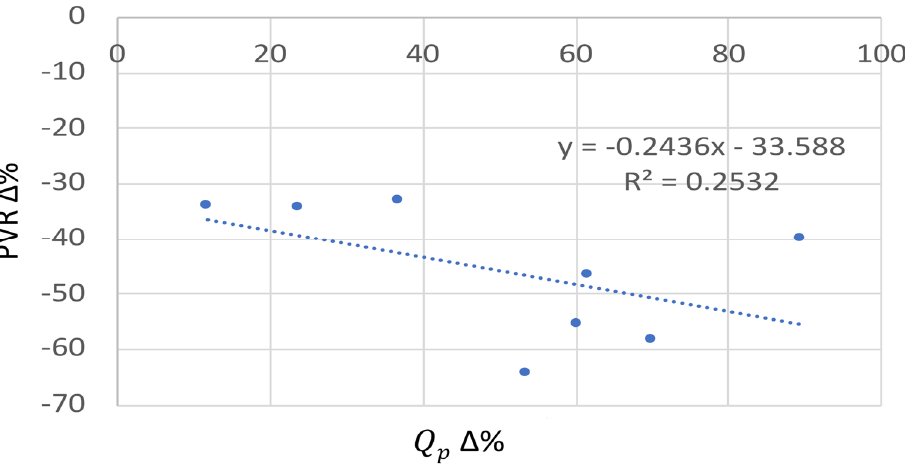
Figure 5. Correlation for percent of PVR reduction to percent of pulmonary flow